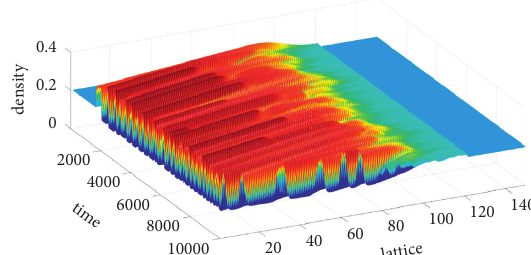
Figure 1: Spatiotemporal evolution pattern.